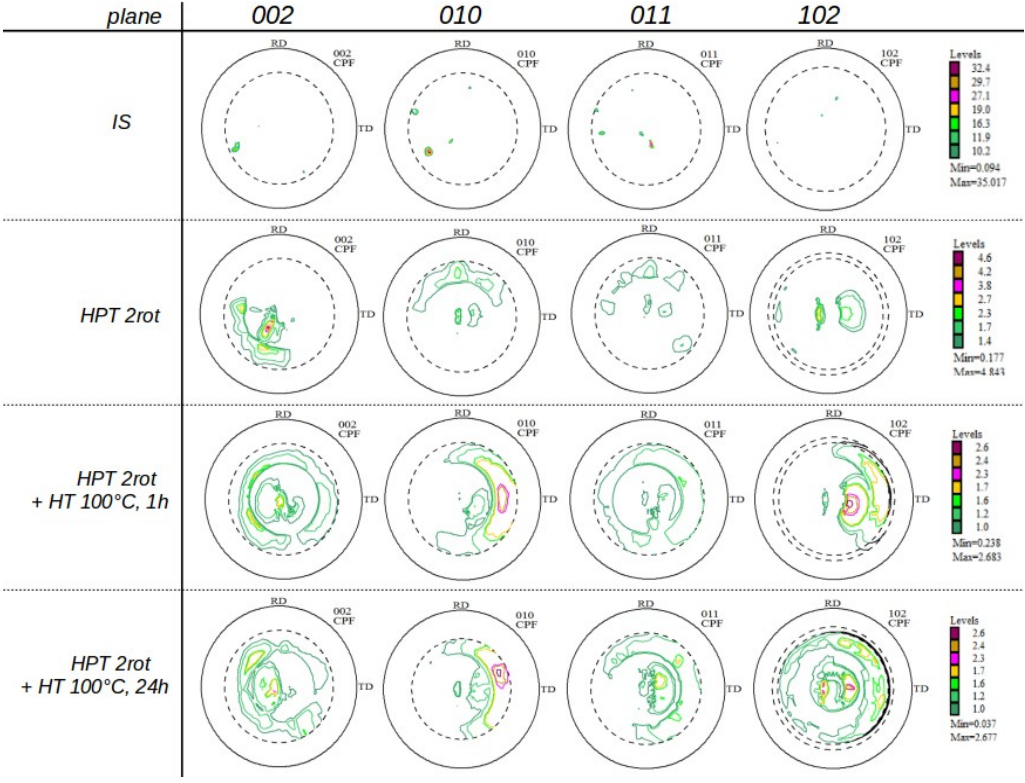
Figure 14. Pole figures displaying crystallographic textures of Mg5Zn0.3Ca samples in the IS (furnace ‐ cooled) and HPT ‐ processed by 2 rotations (torsional strain γ T ~8) and additional heat treatment at 100 °C for 1 and 24 h.